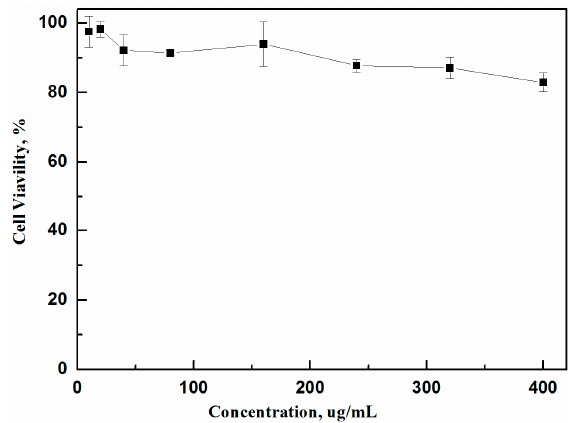
Figure 5. Cytotoxicity of PPSD.